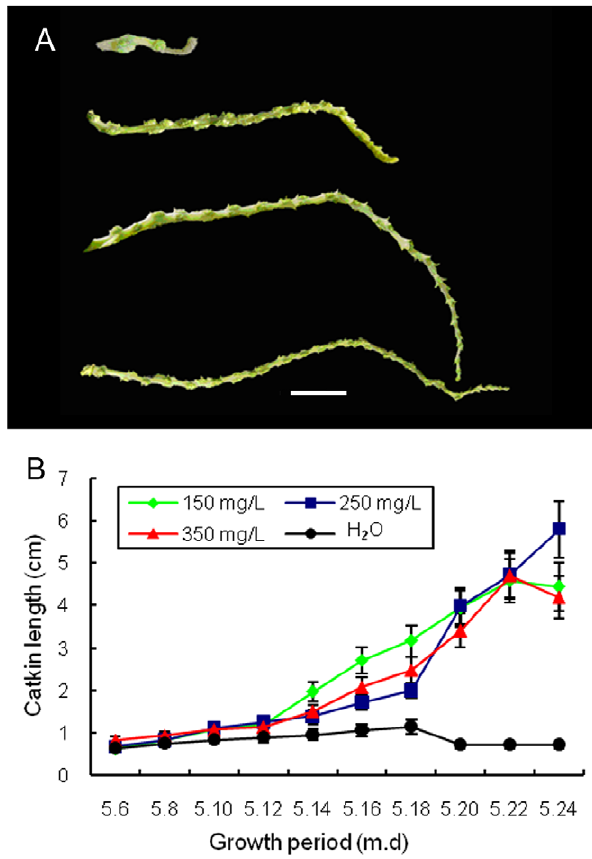
Figure 5. PP 333 treatment on the wild-type catkins. ( A ) Catkins from up to down were treatment by H 2 O, 500 mg/L, 1000 mg/L and 1500 mg/L of PP 333 on wild-type catkins every two days during growth period in year 2007 and length changes were recorded. Bar =1 cm. ( B ) The average length of wild-type catkins after different concentrations of PP 333 treatment. Data are means ( 6 SE, n=30).